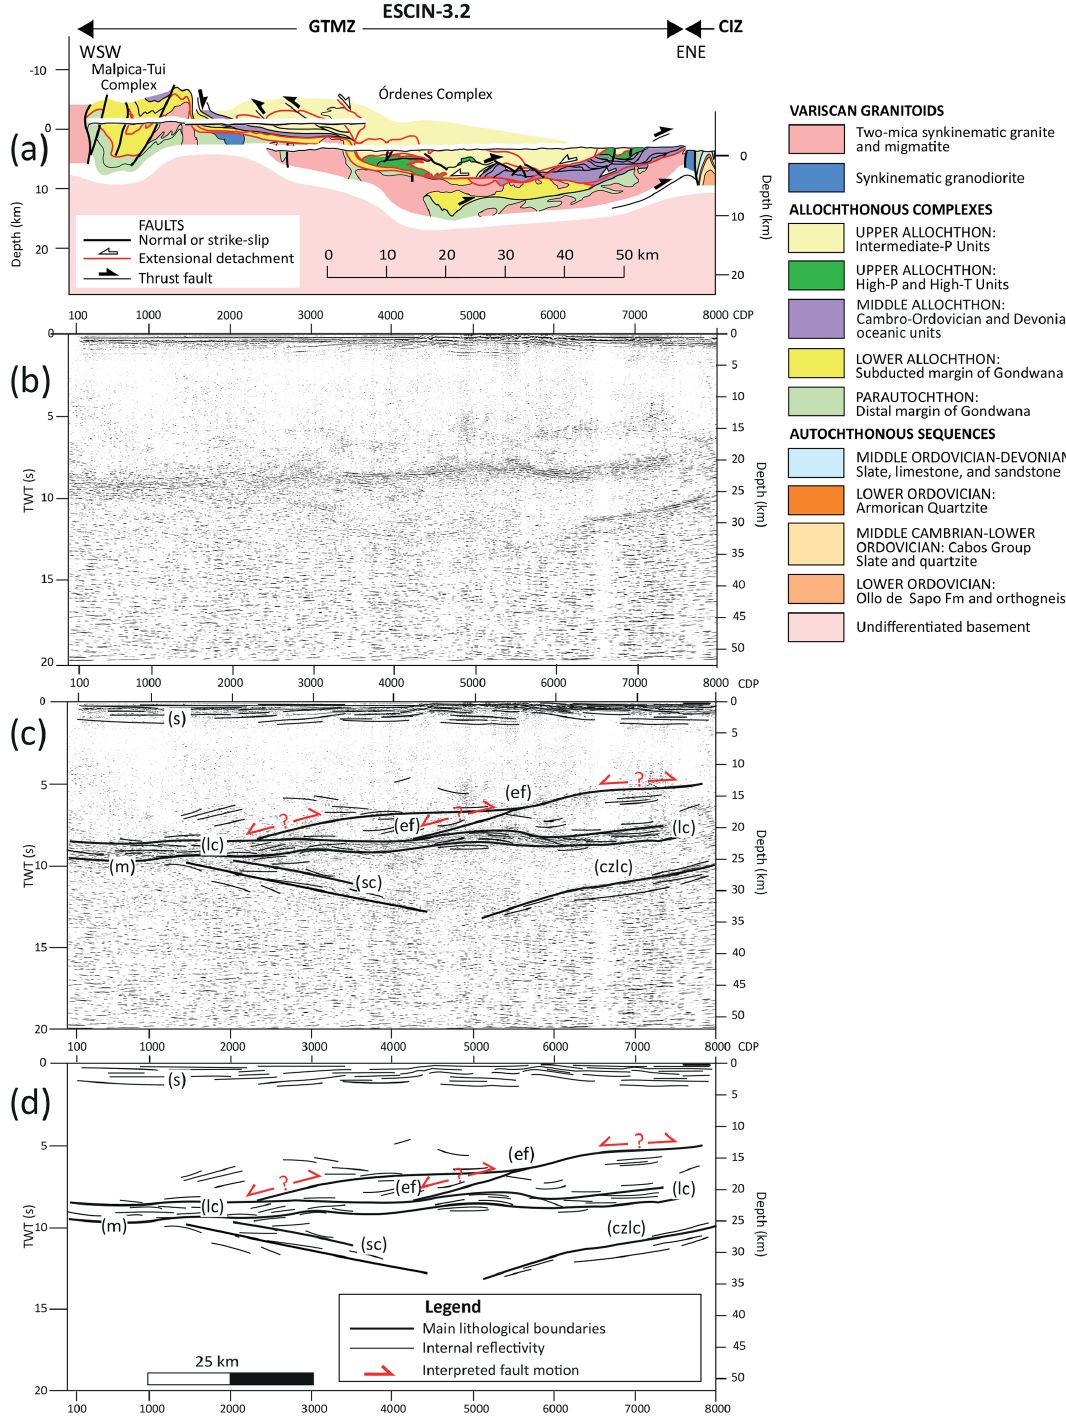
Figure 6. Cross section (a) and depth-converted time-migrated section ( v = 5200m/s) of the NI seismic profile ESCIN-3.2 (Fig. 1), with- out (b) and with (c) interpretation. A sketch of the most important features is presented in panel (d) . The abbreviations used in the figure are as follows: CDP is the common depth point, TWT is the two-way travel time, GTMZ is the Galicia-Trás-os-Montes Zone, CIZ is the Central Iberian Zone. The nomenclature for reflections is as follows: (s) is sediments, (ef) denotes extensional features, (lc) is the lower crust, (m) is the Moho, (sc) denotes subcrustal reflections, and (czlc) is the CZ underthrusted lower crust. Depth conversion is based on migration